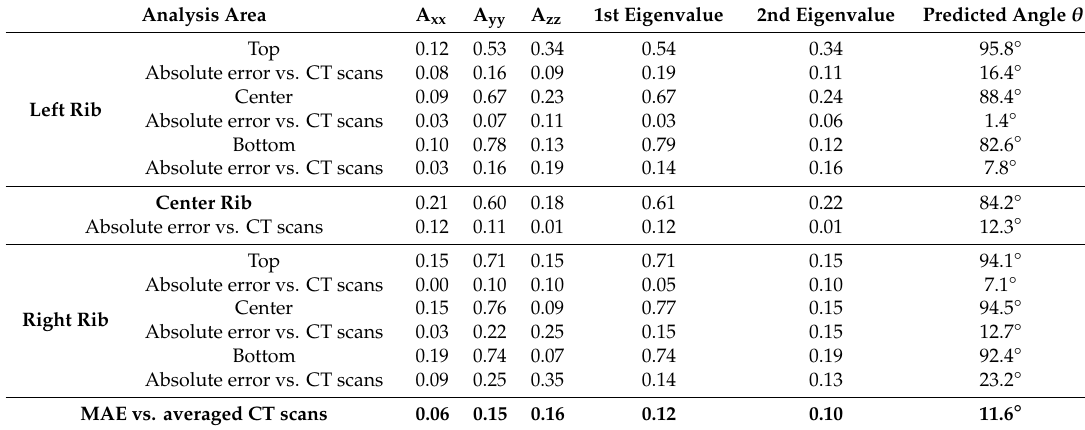
Table 8. Predicted fiber orientation results for the rib analysis areas of the ribbed hat profile using 3D TIMON CompositePRESS.